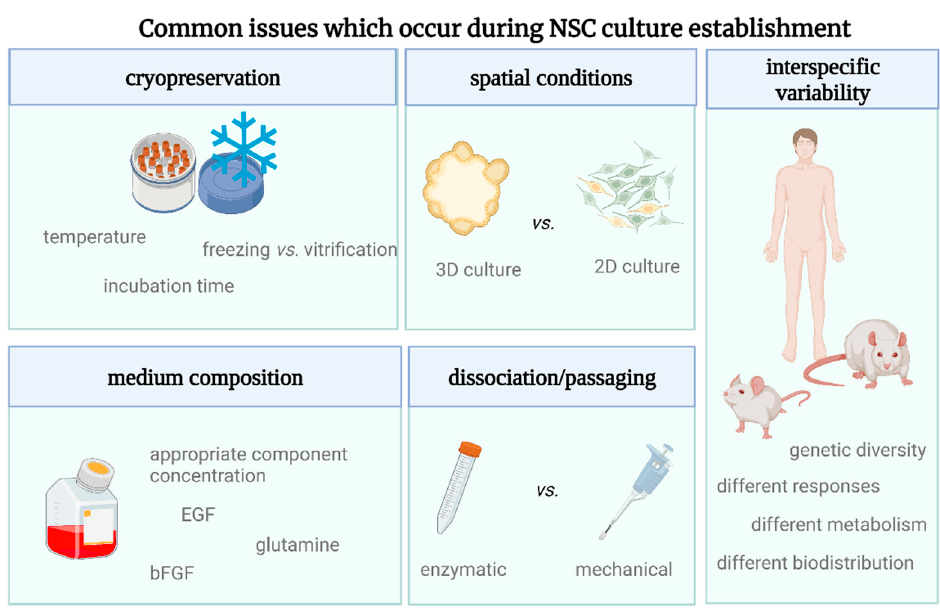
Figure 2. A variety of culture establishment options regarding NSCs’ cultivation.